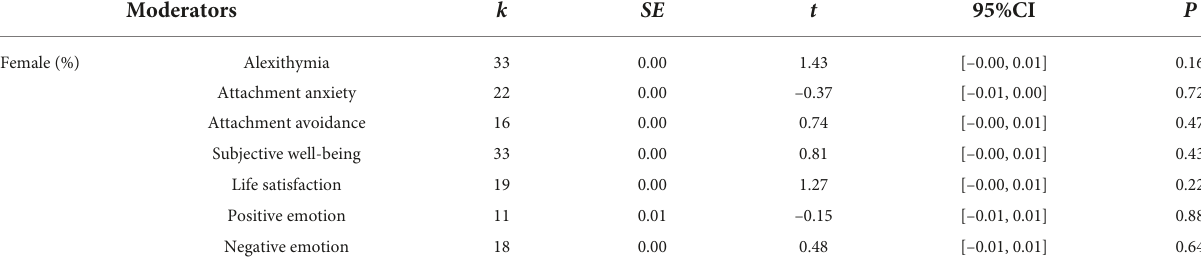
TABLE 4 Univariate regression analysis of continuous variables (random effect